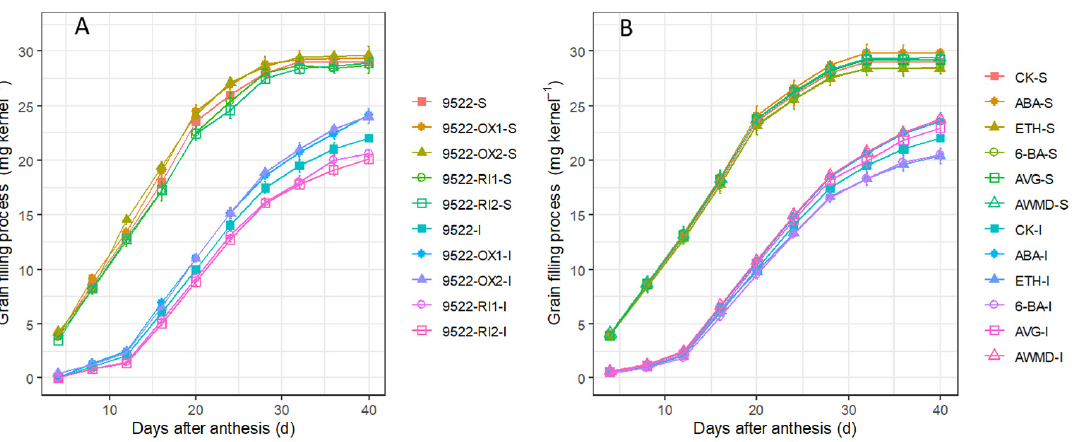
Figure 9. Grain-filling processes of superior (S) and inferior (I) spikelets of wildtype and transgenic lines ( A ), and application of exogenous phytohormone/alternate wetting and under moderate drying (AWMD) irrigation ( B ) at harvest stage. Symbols and significance levels are as described in Figure 1.